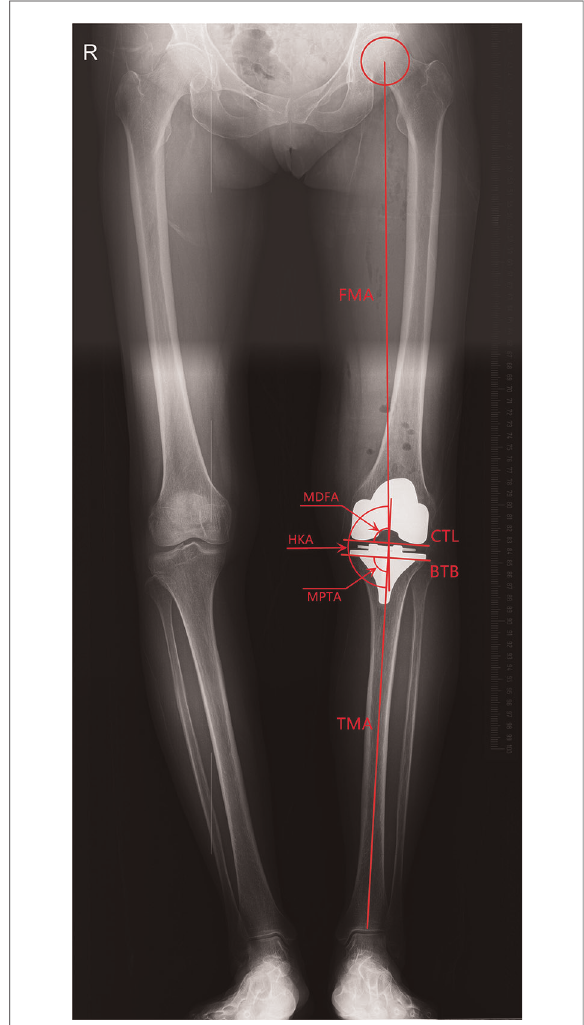
FIGURE 1 Measurement on the coronal plane (FMA, femoral mechanical axis: a line connecting the centers of the femoral head and knee joint; CTL, condylar tangent line; BTB, border of tibial baseplate; TMA, tibial mechanical axis: a line connecting the centers of the knee joint and ankle joint; MDFA, medical distal femoral angle; MPTA, medical proximal tibial angle; HKA, medical angle between FMA and